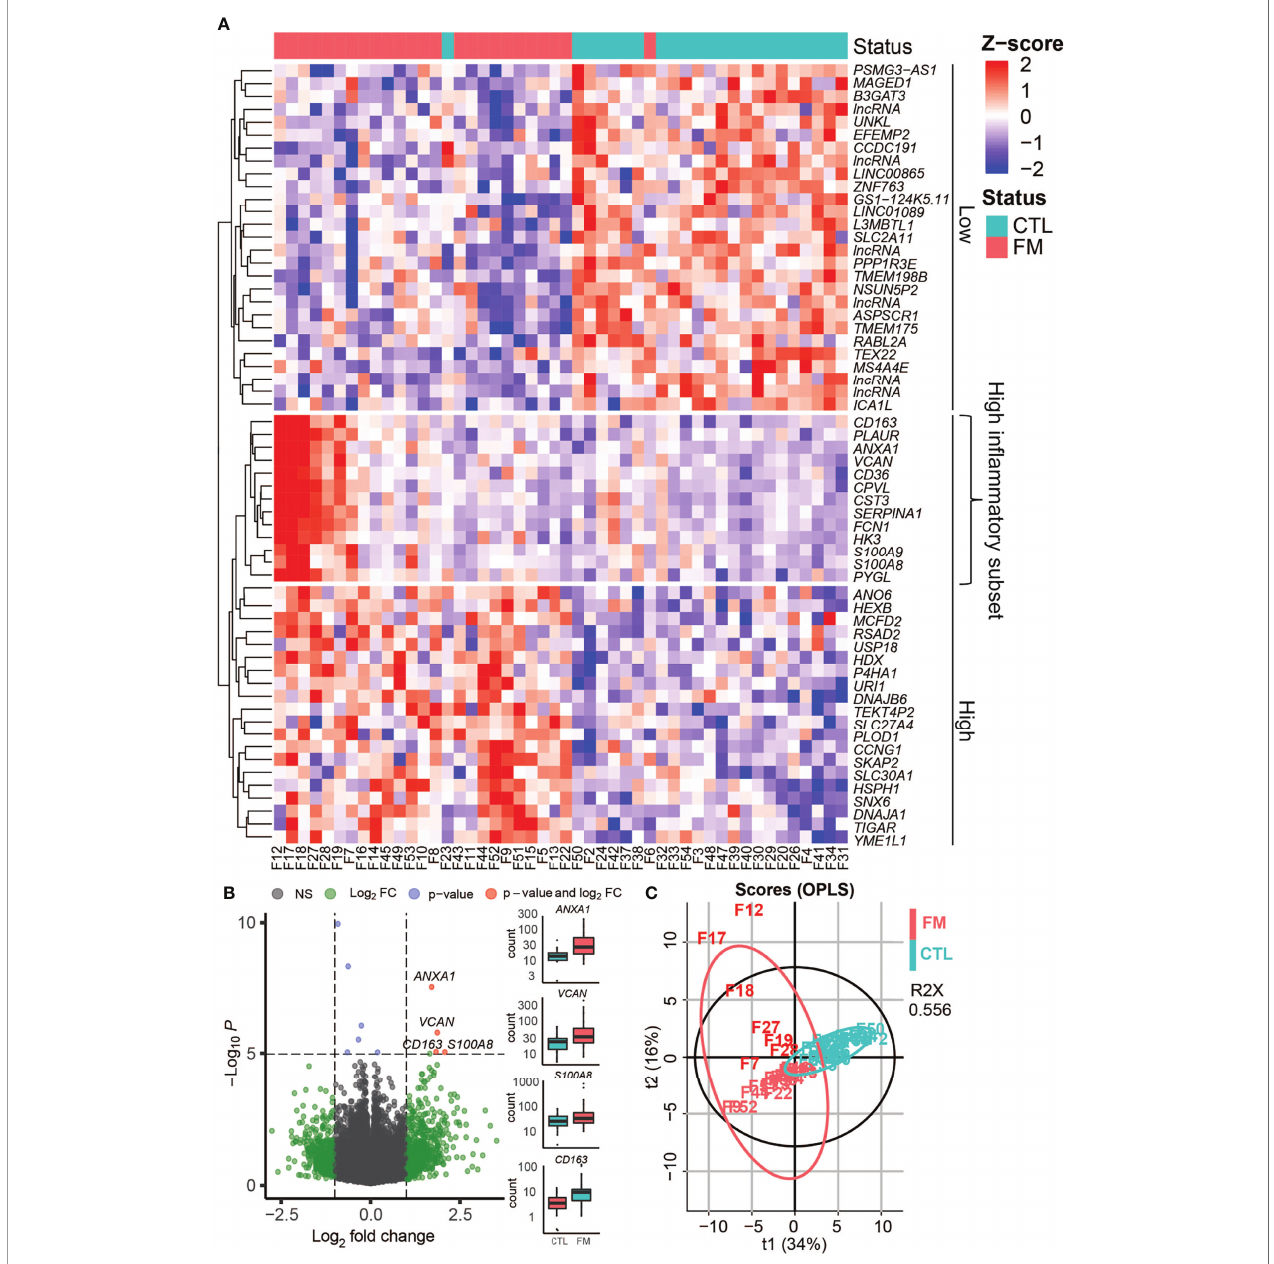
FIGURE 1 | Gene expression pro fi leinB-cells of FMpatients compared to controls(CTL). Gene expression pro fi leinB-cellsof FMpatientes compared to controls(CTL). (A) Heat-map shows differentially expressedgenes in 25 FMpatients vs. 23 control individuals. The genes are grouped ifthey show a lower expression in FMpatients (Low) or a higher expression inFM patients (High). A group ofin fl ammatory genes with a very high expression in seven patients isindicated (High in fl ammatorysubset). (B) Volcano plot illustrating differentially expressedgenes (green and red dots)in the25 FMpatients vs. 23 control individuals. A marked difference isshownfor genes with a strong connection to in fl ammation and autoimmunity such as ANXA1, VCAM, CD163, S100A8 . (C) OPLSanalysis of differentially expressedgenes in FM patients (light red)vs. controls(magenta) allowedfor a separation ofthe subset ofFM patients with high expression ofin fl ammatory genes (F7, F12, F17, F18, F19, F27, F28; dark